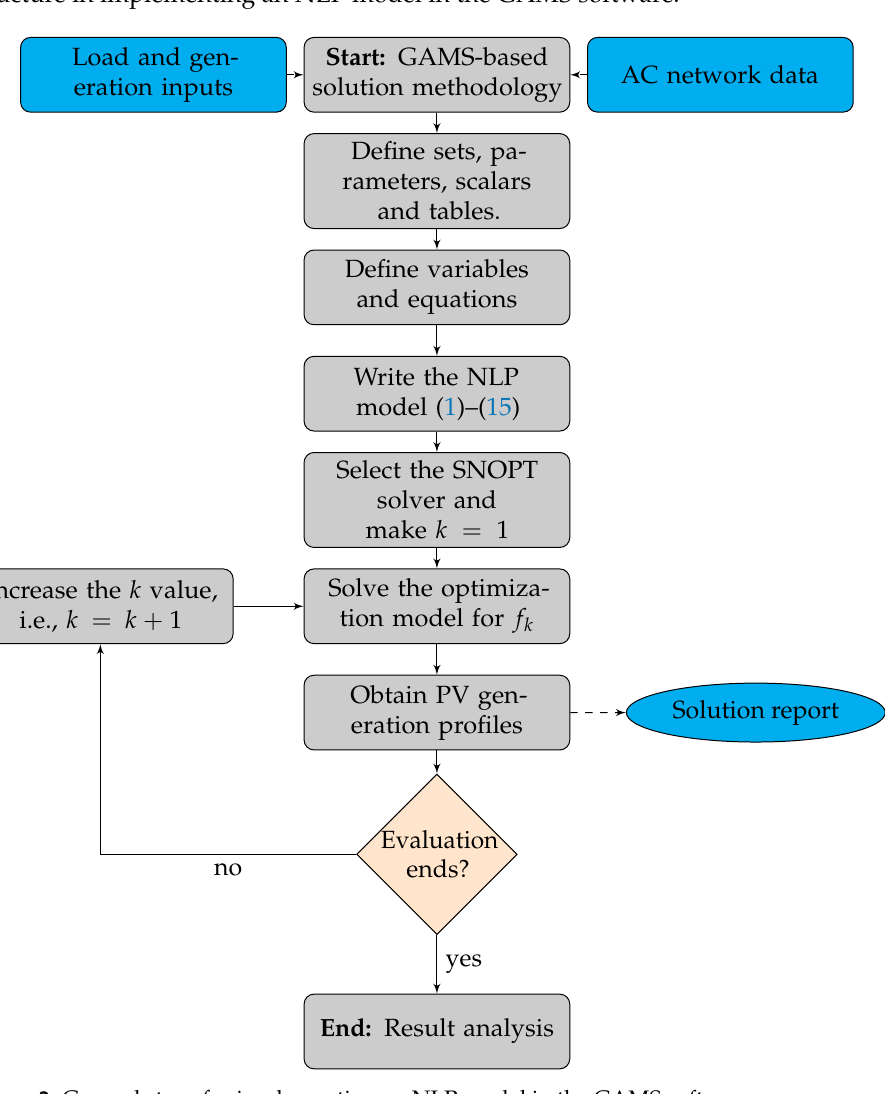
Figure 2. General steps for implementing an NLP model in the GAMS